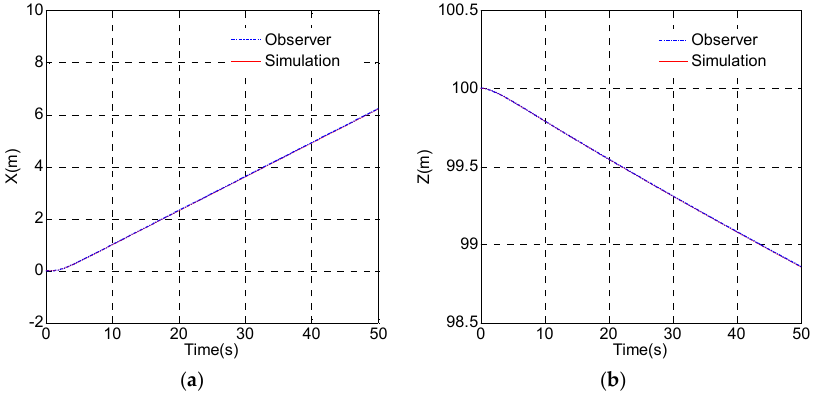
Figure 15. Observed result of ROV position: ( a ) X; ( b ) Z.